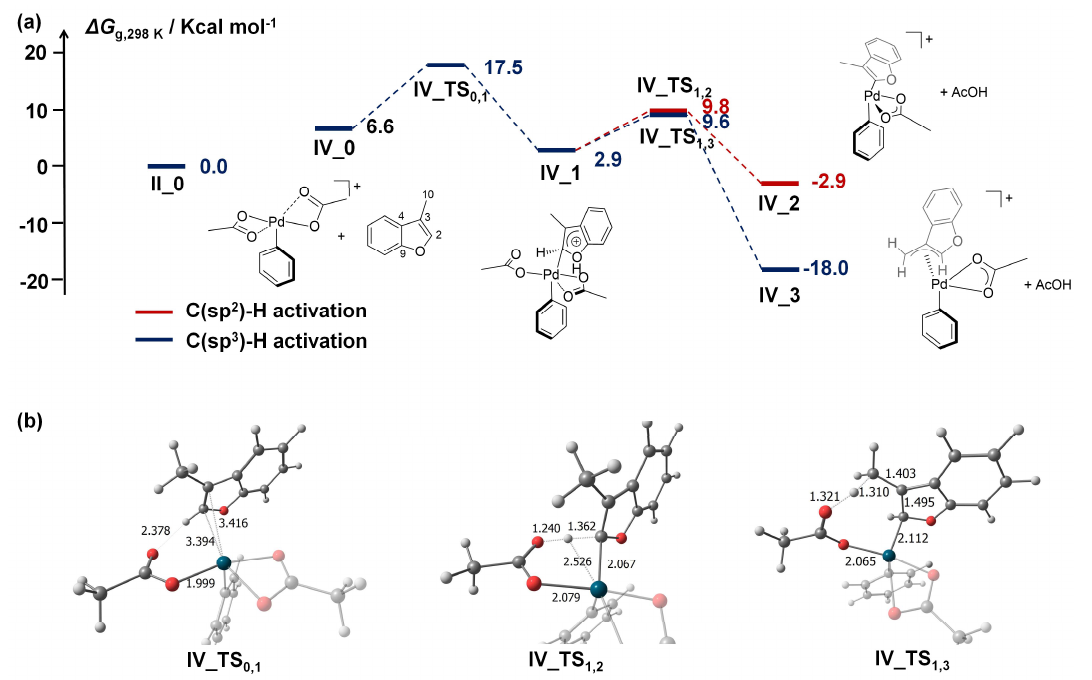
Figure 5. ( a ) Free energy reaction profile for C(sp 2 )−H (red) and C(sp 3 )−H (blue) activation by IV . Numbers are Δ G in water at 298 °C (energies in kcal/mol). ( b ) Optimized geometries of transition states with selected bond lengths (Å). The spectator acetate and phenyl groups are drawn translucent for clarity. Upon substrate addition with its long axis orthogonal to the z-axis of IV , when the axis containing the phenyl group is set as the z-axis, the equatorial coordination site of IV , which was left vacant due to the elimination of the iodide ligand (as seen in Figure S1), was reoccupied by the incoming substrate forming an intermediate state IV_1 . It is note- worthy to focus on the structure of IV. The distances between the two oxygen atoms of the